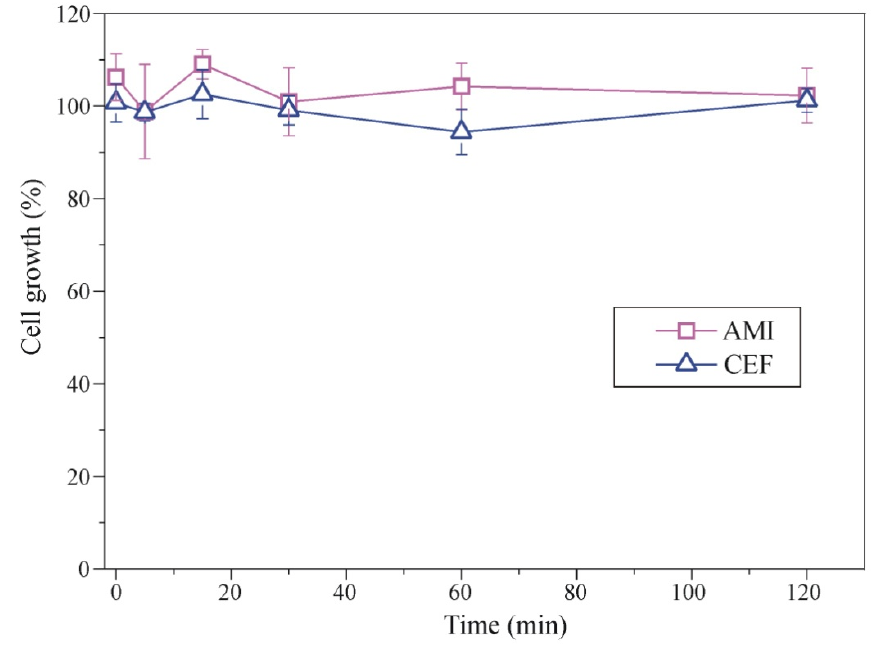
Figure 11. Effect of reaction mixtures of AMI (0.05 mmol/dm 3 ) using TiO 2 (1.0 mg/cm 3 ) and CEF (0.05 mmol/dm 3 ) using MoO 3 (1.0 mg/cm 3 ) and formed intermediates after different irradiation times on the growth of the H-4-II-E cell line.